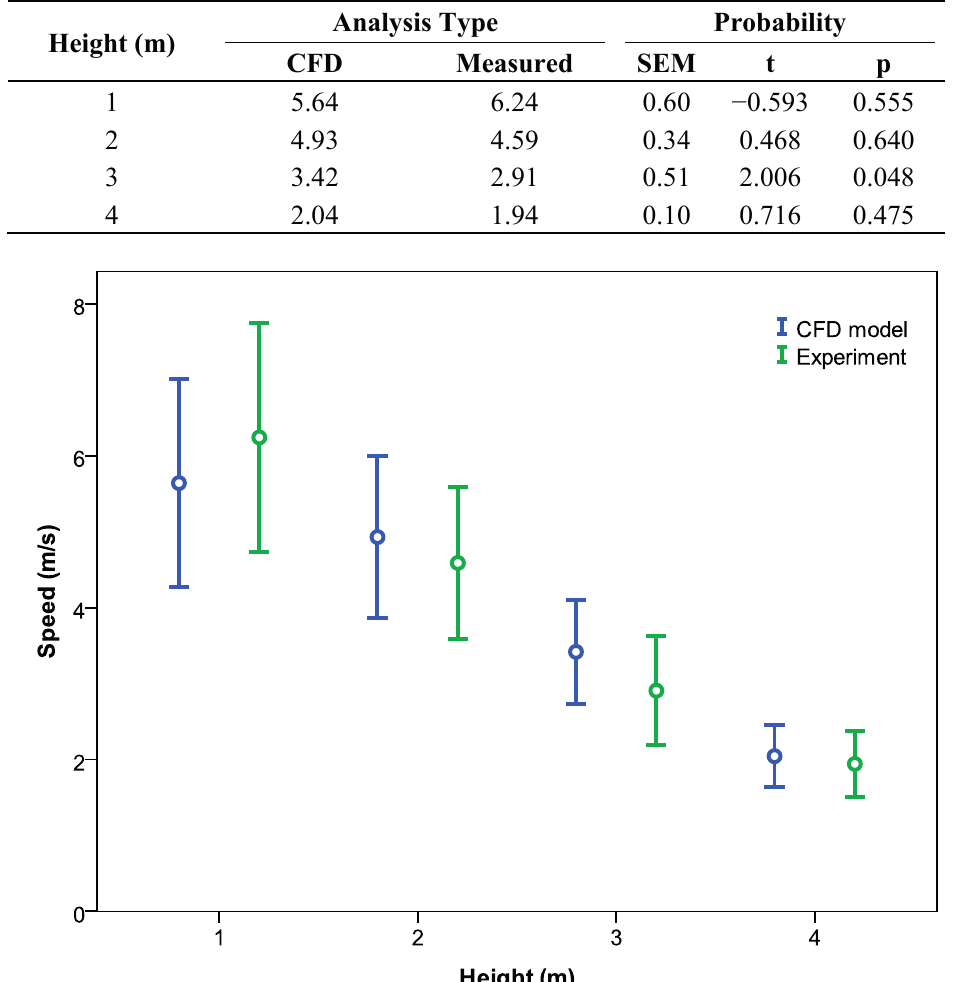
Table 6. Air velocity values according to the analysis type and the height. The Student t test was used to compare the means.